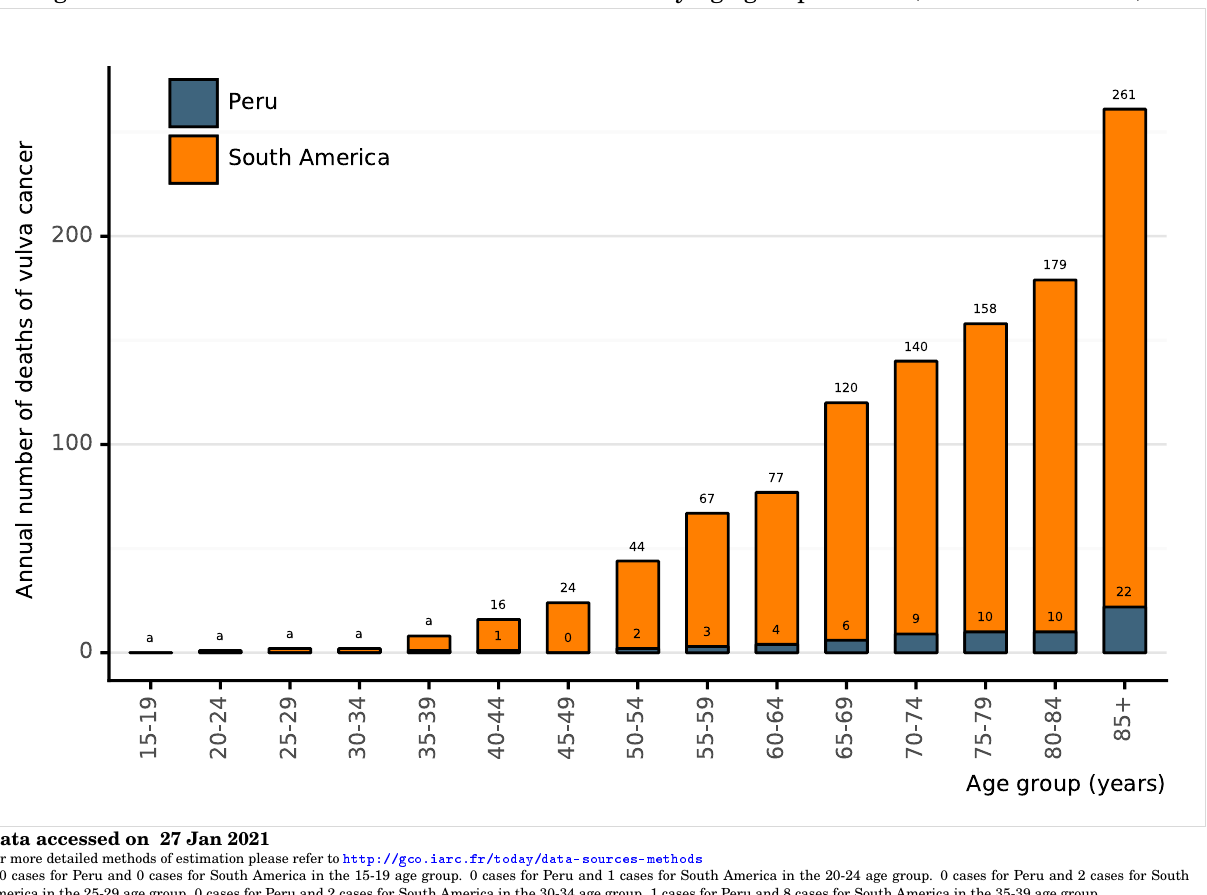
Figure 114: Annual number of deaths of vulva cancer by age group in Peru (estimates for